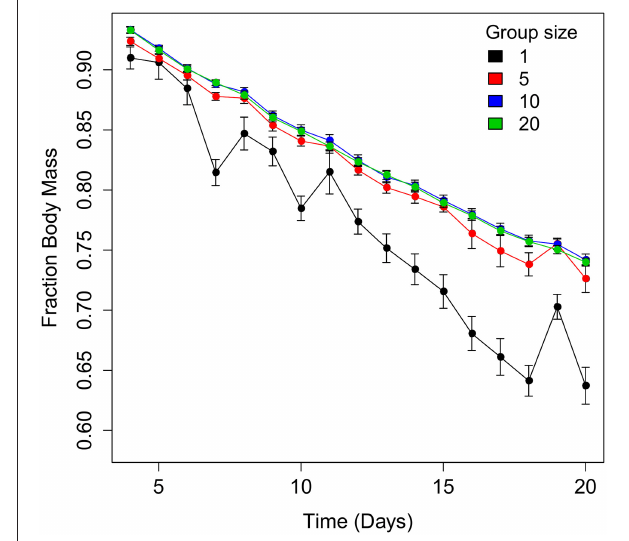
FIGURE 5 | The survival rate of Stegodyphus dumicola spiders at four different group sizes (1, 5, 10, and 20) subjected to desiccation in chambers with relative humidity of < 5% over 44 days.